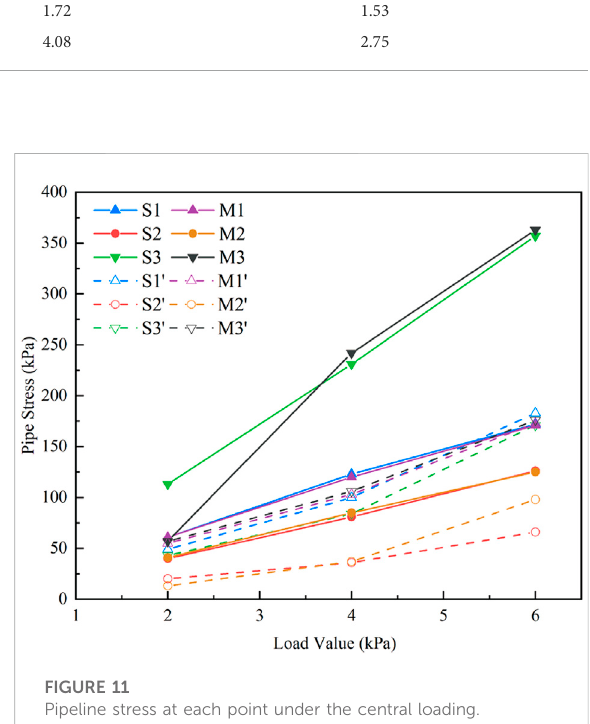
FIGURE 10 Comparison of fi eld test values and theoretical calculation results under 6 kPa load.